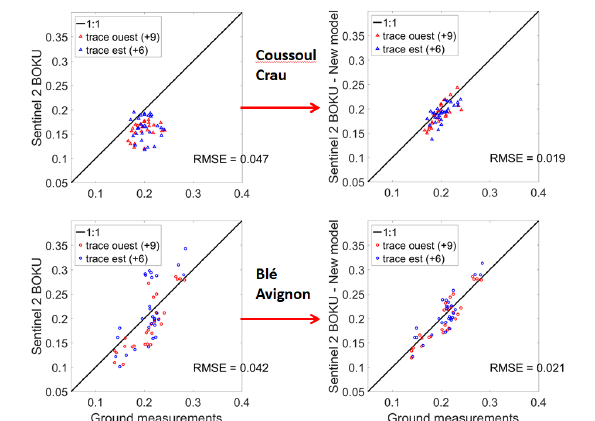
Figure 3 : Comparison of estimated albedo by comparison with ground-based measurement over two sites located at La Crau and in Avignon. Left hand: a unique linear combination. Right hand: a different linear combination for Figure 2: Time series of HR surface albedo products over the each geometry of ICOS stations of CESBIO.